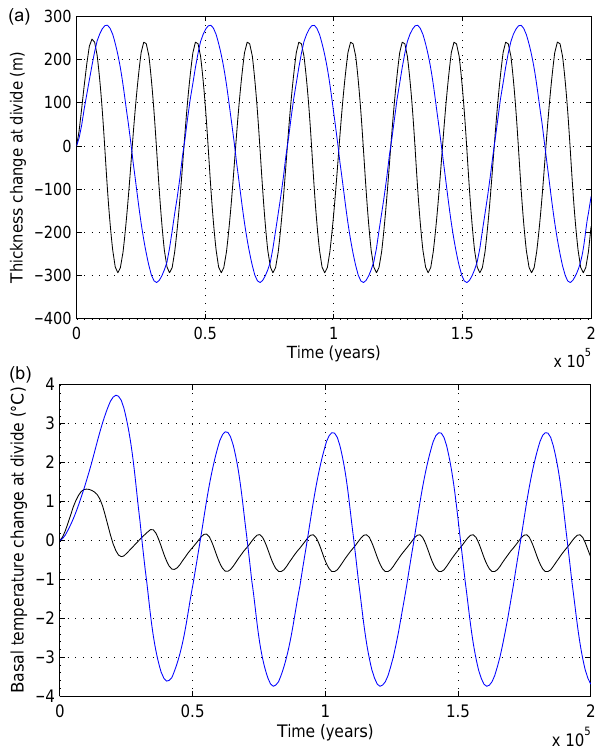
Figure A3. Ice thickness and basal temperature variations for the EISMINT-I moving margin experiment with a 20ka (black) and a 40ka (blue) forcing.